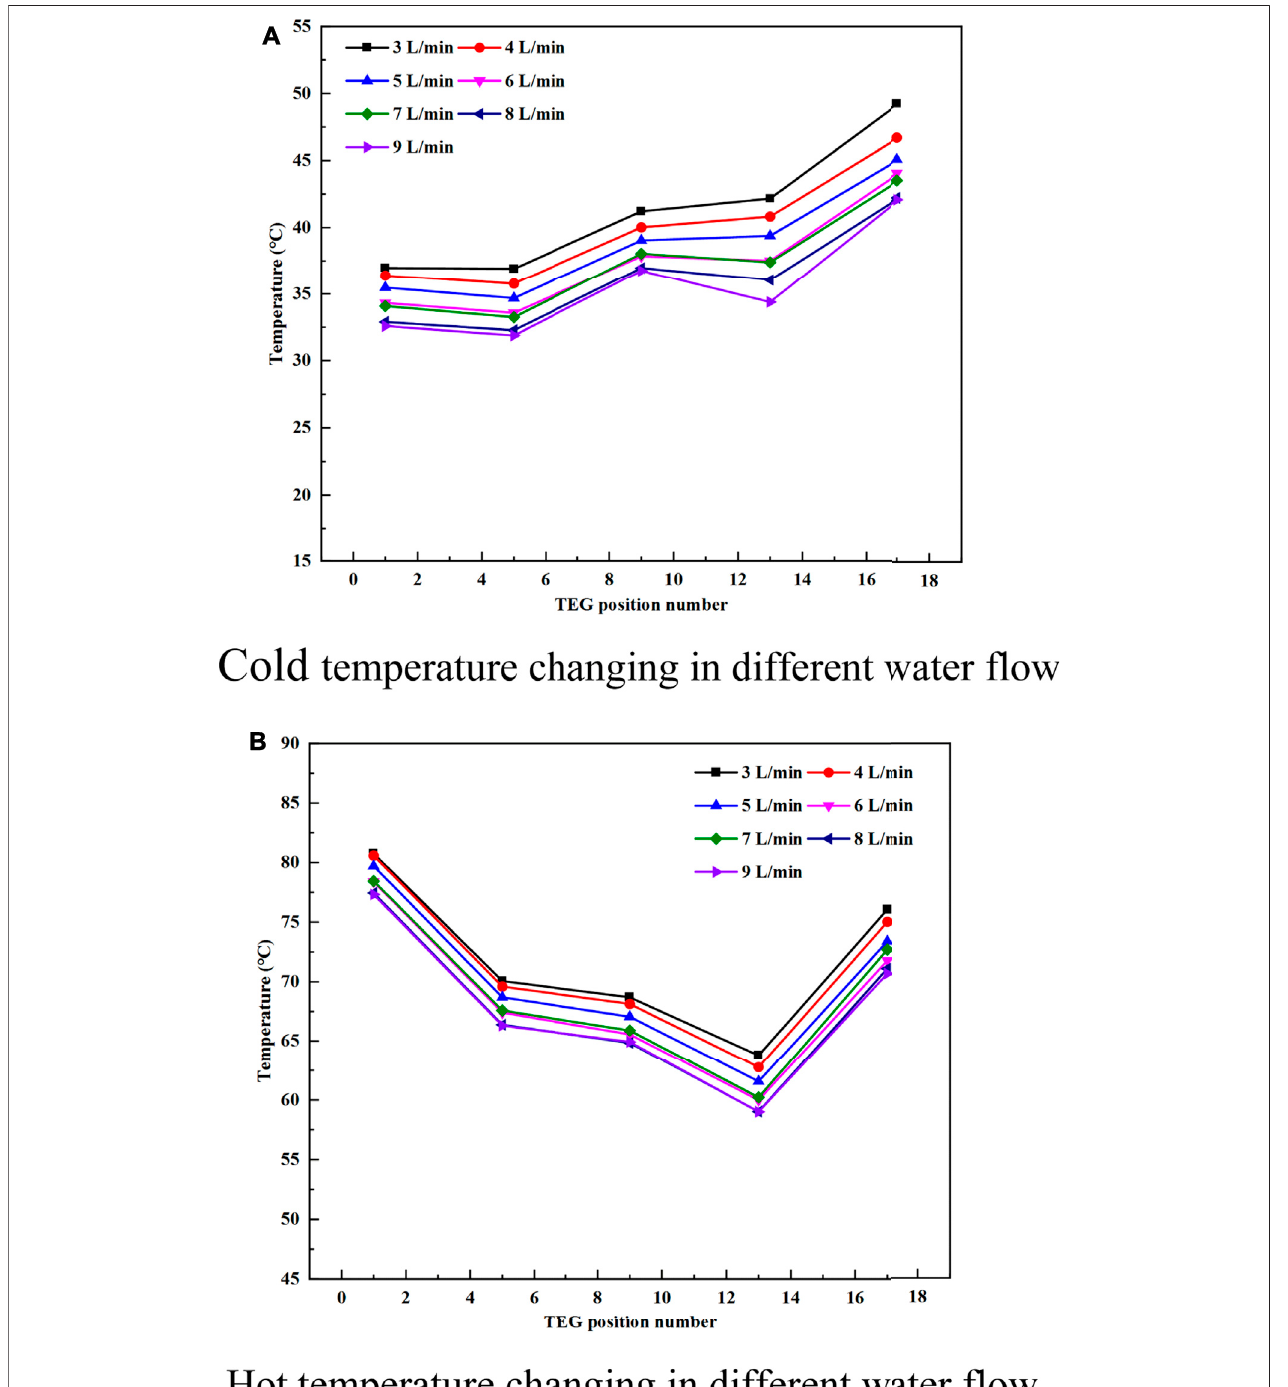
FIGURE 12 | (A) Cold temperature changing in different water fl ows. (B) Hot temperature changing in different water fl ows.